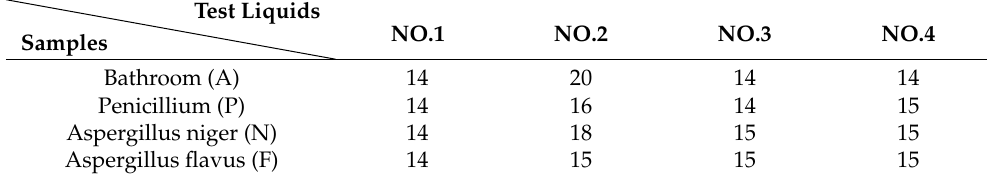
Table 8. Results of microbial test (metal ring), diameter (mm).